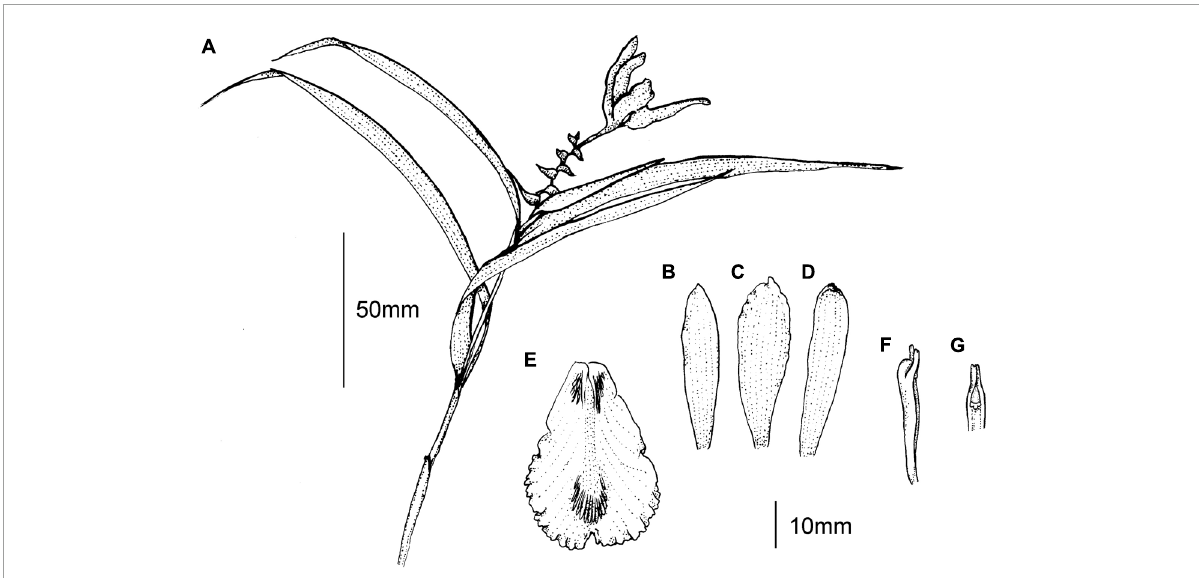
FIGURE6 Sobralia granitica G. A. Romero & Carnevali (A) apical part of stem with inflorescence, (B) dorsal sepal, (C) petal, (D) lateral sepal, (E) lip, (F) gynostemium, side view, and (G) apical part of gynostemium, front view [drawn by P. Baranow, (A) from Rudas et al. 7336 , (B–G) redrawn from Romero-González